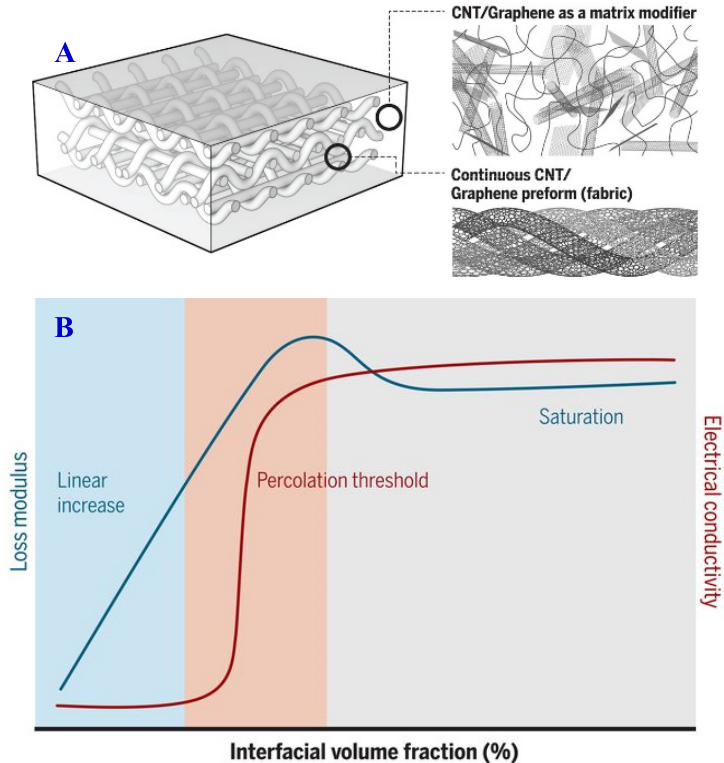
Figure 14. Polymeric composite which consists of both continuous carbon nanotube (CNT) and chemically modified CNT or graphene carbon as matrix modifiers ( A ), and loss modulus and electrical conductivity with respect to interfacial volume fraction in CNT or graphene carbon nanocomposites ( B ) [12].